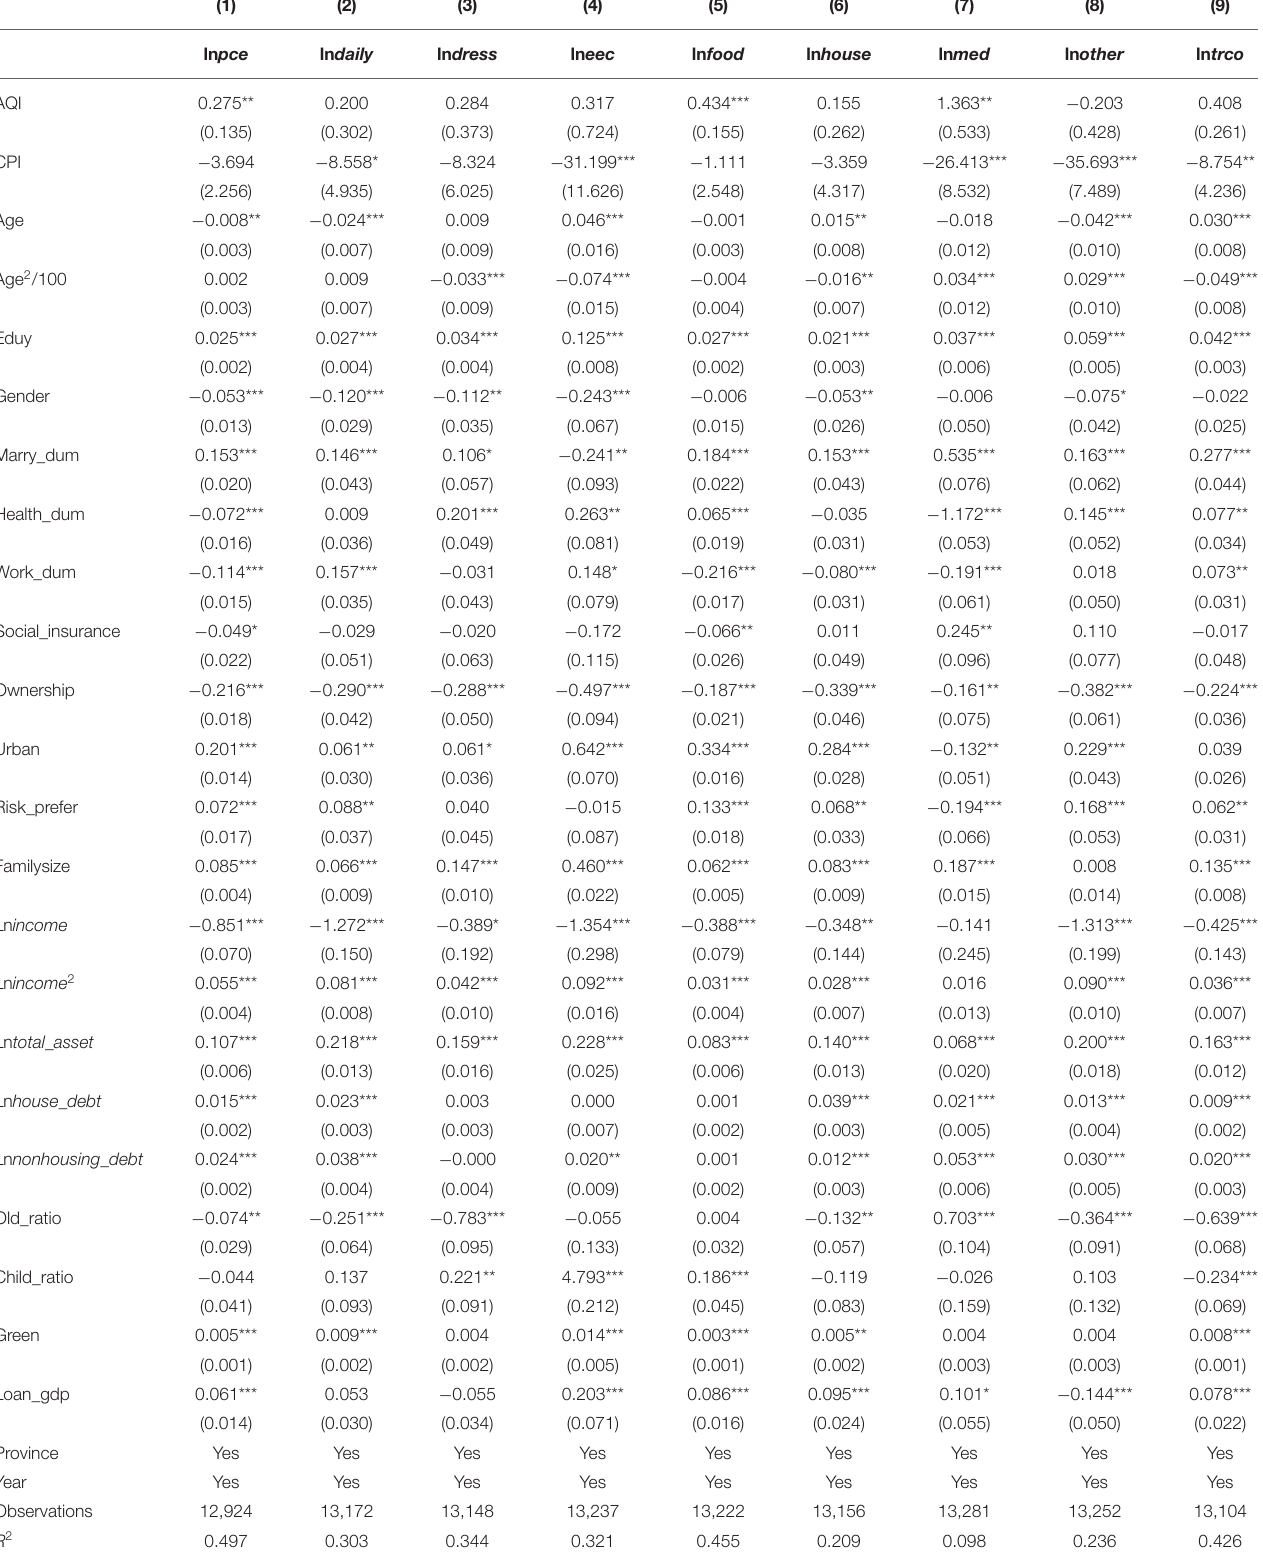
TABLE 2 | Air pollution and household medical expenses: baseline